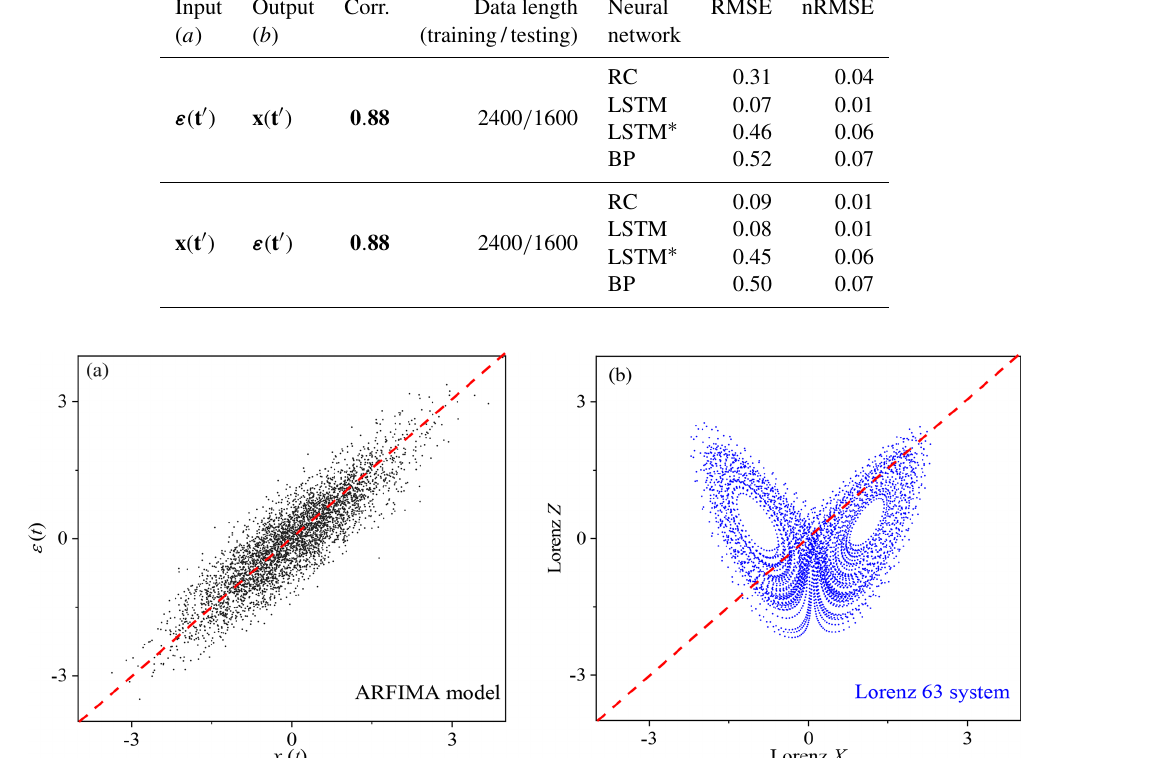
Figure 6. (a) Scatter plot of x ( t ) and ε ( t ) of the ARFIMA (3, 0.2, 3) model. (b) Scatter plot of X time series and Z time series of the Lorenz 63